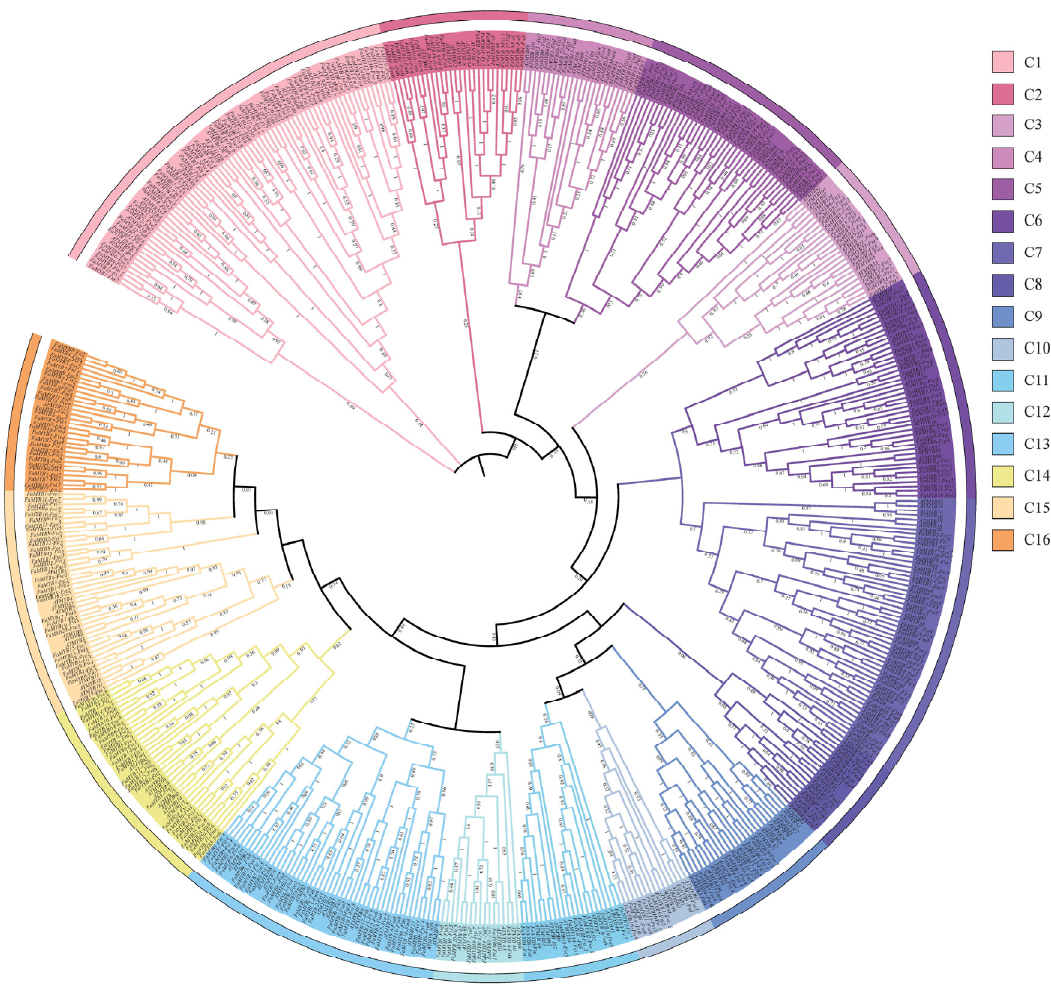
Figure 1. The maximum-likelihood phylogeny of MYB genes of Fragaria × ananassa ( FaMYBs ) and Arabidopsis thaliana (AtMYBs) . Different groups are colored respectively. Numbers on branches are bootstrap values of 1000 replications. Gene IDs of AtMYBs are listed in Table S2.